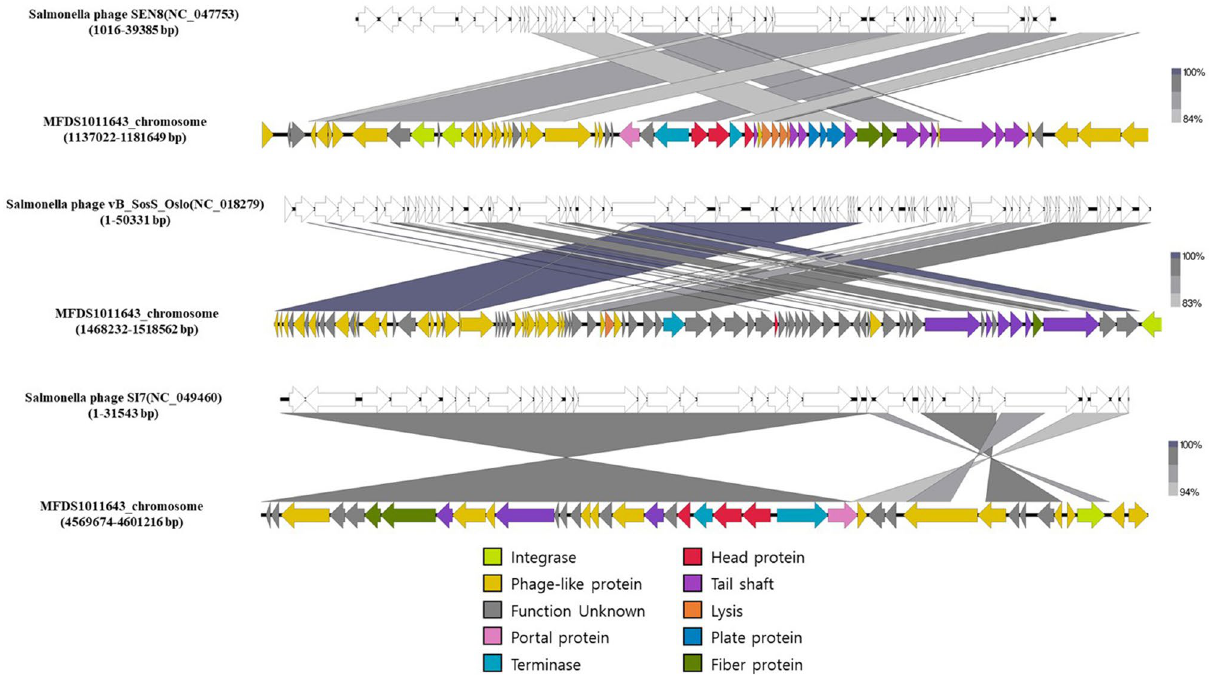
Figure 4. Genomic comparison between phages SEN8, vB_SosS_Oslo, and SI7 of MFDS1011643 strain, which was the main source of infection, and the most closely related phages (NC_047753, NC_018279, and NC_049460). Phage genomes are presented via linear visualization, with coding regions shown as arrows. Selected open reading frames are colored in relation to their functions , as indicated in the legend at the bottom. The percentage of sequence similarity is indicated by the intensity of the gray color. Figure was generated using Easyfig v. 2.2.5 (https:// mjsull. github. io/ Easyfi